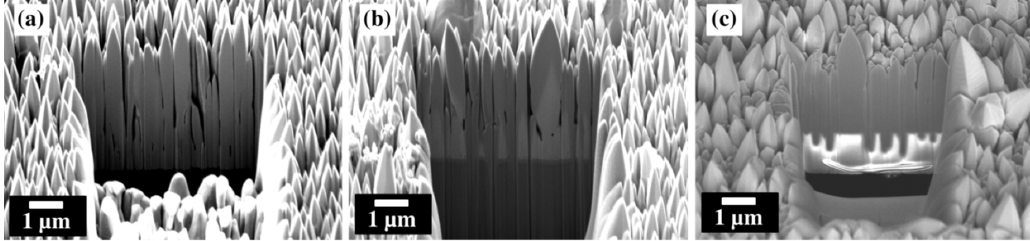
Figure 8. Cross-sectional SEM micrographs after focused ion beam milling of ZnO nanowhiskers grown on ( a ) n-doped Si, ( b ) Ti, and ( c ) a Ti-coated SiN membrane. The SEM images were taken with a tilting angle of 54°.